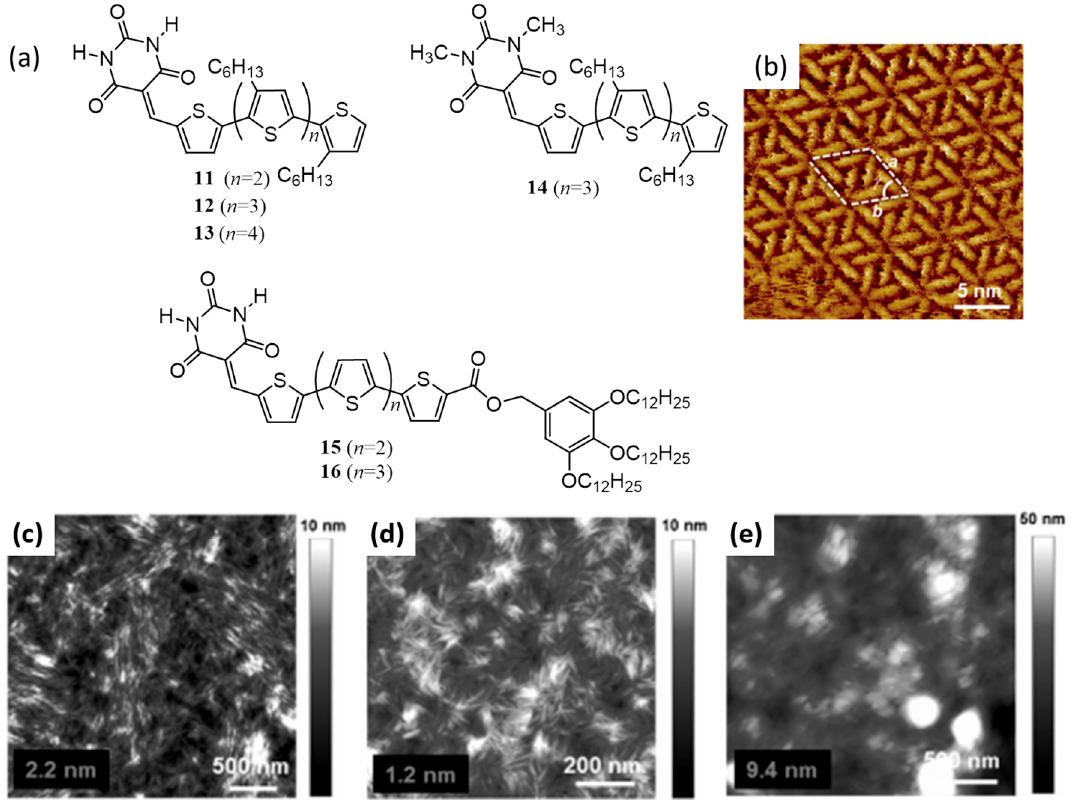
Figure 6. ( a ) Chemical structure of barbiturate-conjugated thienyl-[oligo(hexylthiophene)]s ( 11 – 16 ) synthesized by Yagai et al. [53]. ( b ) STM image of 13 on the 1-phenyloctane-highly oriented pyrolytic graphite (HOPG) interface. AFM topography images of the 1:1 ( w / w ) blend films of ( c ) 11 /PC 61 BM; ( d ) 12 /PC 61 BM and ( e ) 13 /PC 61 BM after annealing at 80 °C. The values at the bottom-left corner are root-mean-square (RMS) roughness. Adapted with permission from Ref. [53] Copyright 2014 WILEY-VCH Verlag GmbH & Co., KGaA.